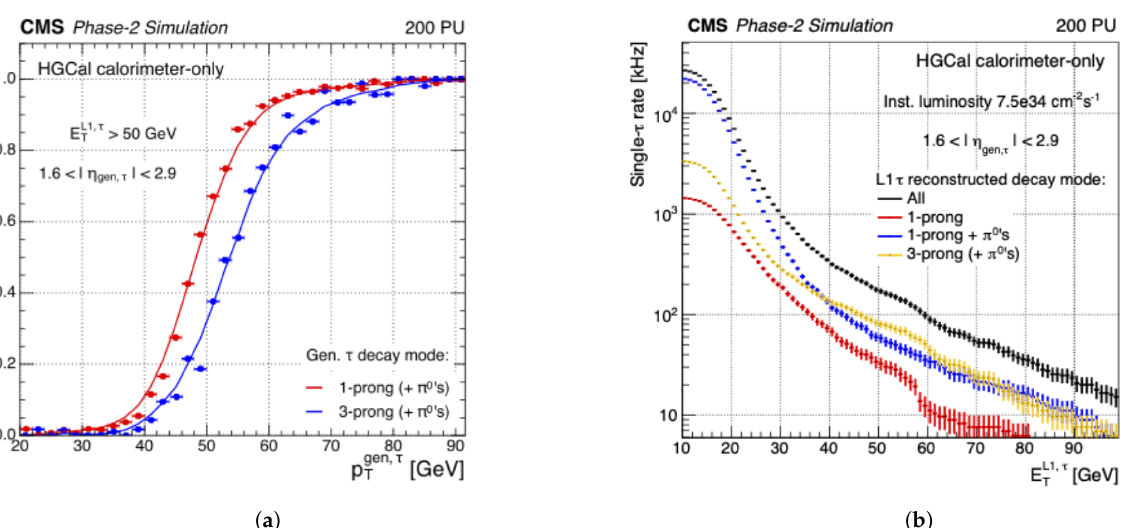
Figure 11. Standalone hadronic τ performance: ( a ) trigger efficiency as a function of the generator- level τ lepton p T for 1-prong (red) and 3-prong τ leptons; ( b ) L1 trigger rates as a function of the τ lepton L1 E T , for inclusive (black), 1-prong (red), 1-prong + π 0 (blue) and 3-prong (yellow) τ lepton